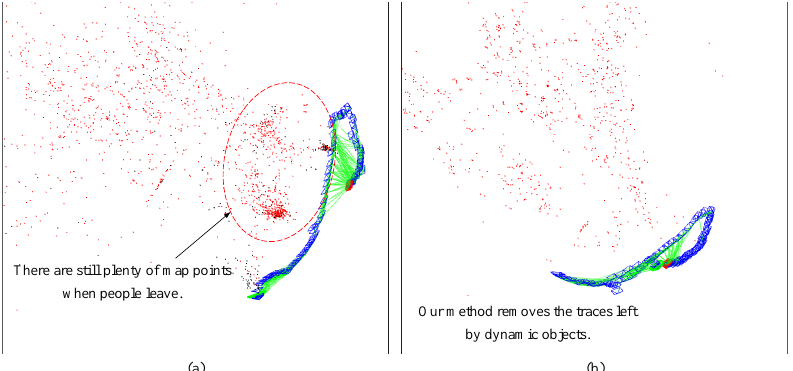
Figure 3. The difference of the generated map between ORB-SLAM3 and our SLAM: ( a ) the result of ORB-SLAM3; ( b ) the result of our method. There are some dynamic map points left after dynamic objects are gone in Figure 3a. Compared with ORB-SLAM3, the results in Figure 3b indicate that our algorithm can deal with these map points